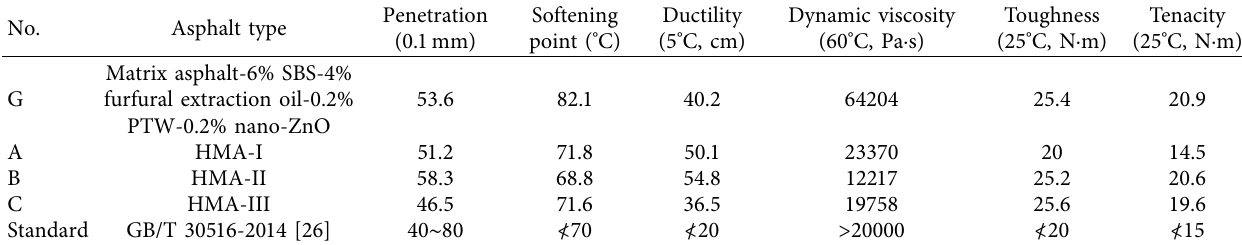
Table 9: Test results of physical properties of modified asphalt.